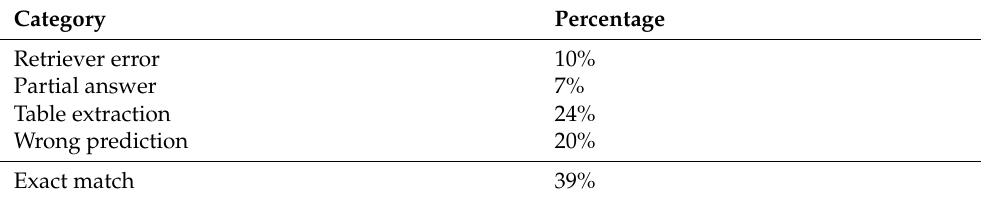
Table 5. Manual error analysis results on AWS Documentation